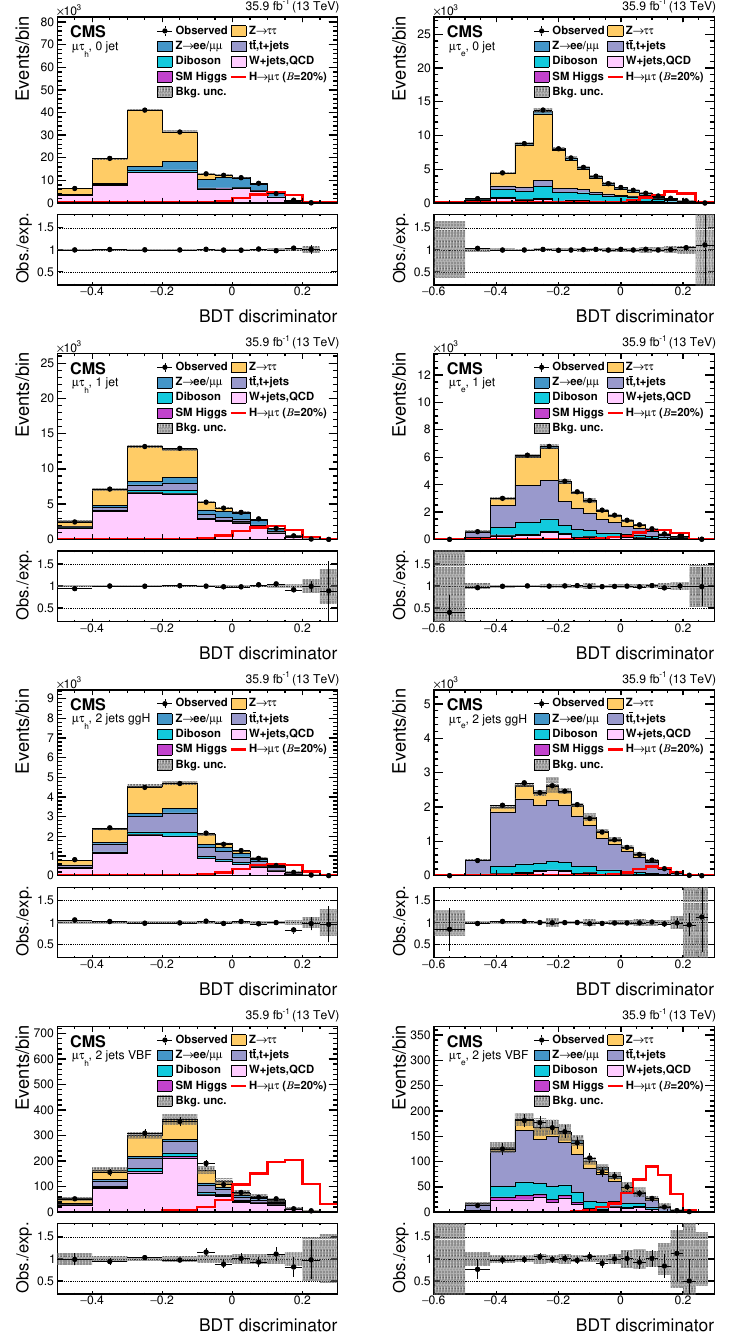
Figure 4 . Distribution of the BDT discriminator for the H ! (cid:22)(cid:28) process in the BDT (cid:12)t analysis, in the individual channels and categories compared to the signal and background estimation. The background is normalized to the best (cid:12)t values from the signal plus background (cid:12)t while the simulated signal corresponds to B (H ! (cid:22)(cid:28) ) = 5%. The bottom panel in each plot shows the fractional di(cid:11)erence between the observed data and the (cid:12)tted background. The left column of plots corresponds to the H ! (cid:22)(cid:28) h categories, from 0-jets ((cid:12)rst row) to 2-jets VBF (fourth row). The right one to their H ! (cid:22)(cid:28) e counterparts.